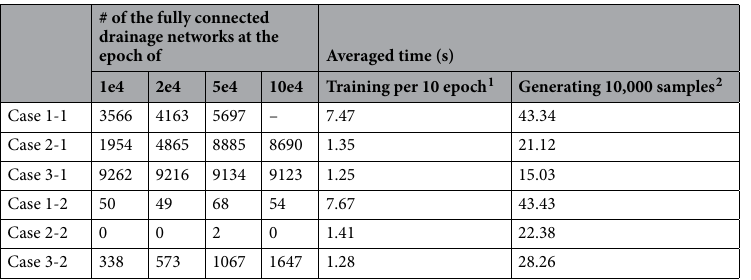
Table 3. Drainage network generation performance on connectivity reproduction and computational training efficiency. The number of fully connected drainage networks among the generated 10,000 drainage network samples were measured at four different numbers of epochs. 1 NVIDIA K80 GPUs, Intel Xeon E5-2686 v4 62